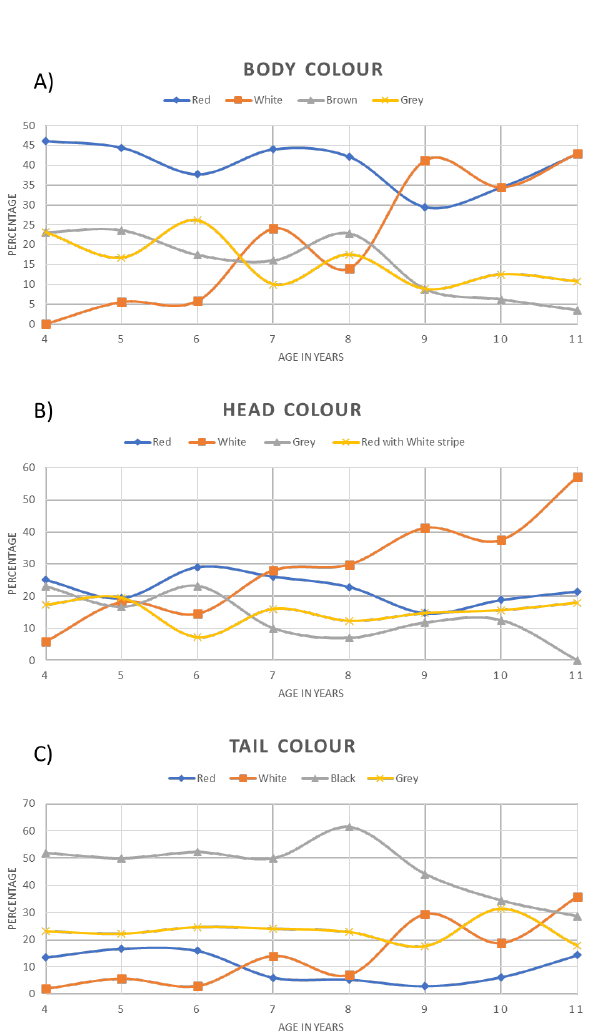
Figure 4. Effect of age on colour characteristics of horse populations. A) Body colour; B) Head colour; C) Tail